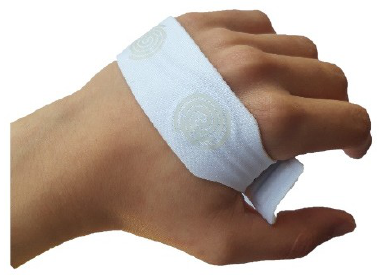
Figure 13. iHandU adapted textile band in closed mode.